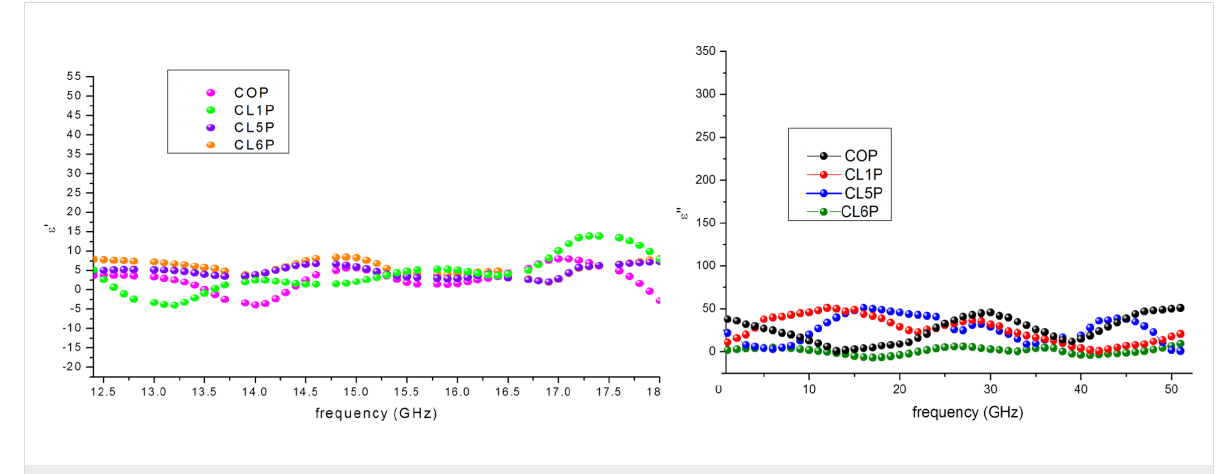
far lower. It has been concluded that the magnetic properties have a considerable effect on the radiation absorption. Consecu- tive peaks of radiation loss of about − 20 dB are present in the plots. ESR spectra show the participation of polyaniline elec- trons in increasing the intensity of the signal. TEM micro- graphs reveal the enclosure of ferrite particles in